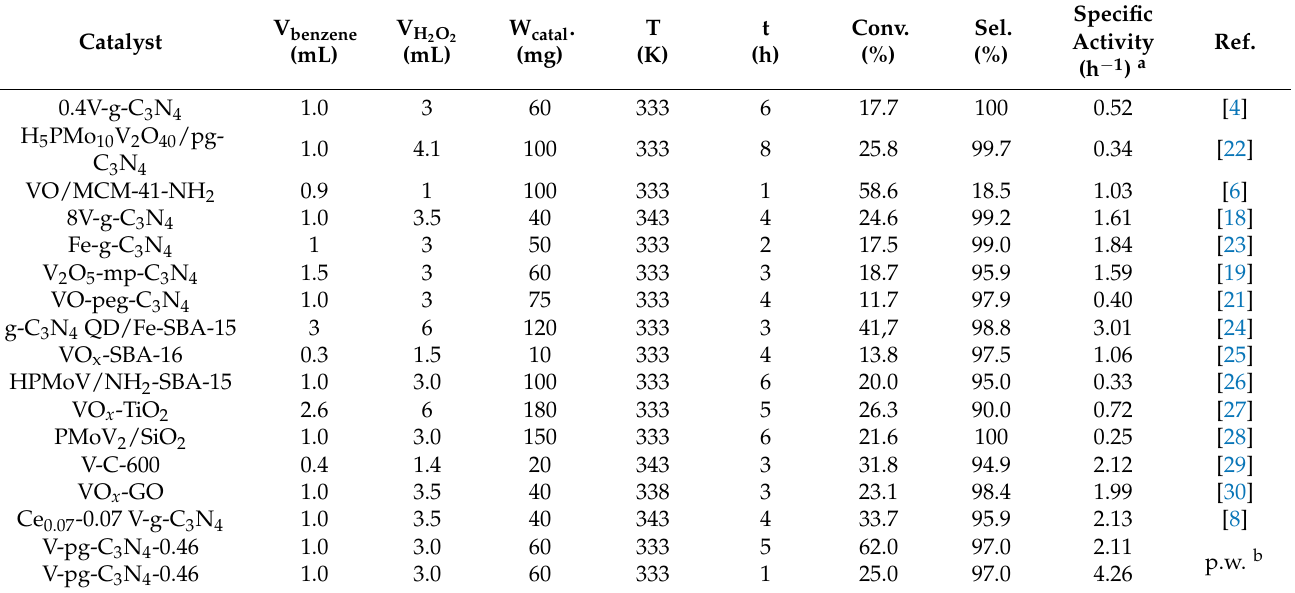
Table 1. The catalytic activity of various vanadia- and g-C 3 N 4 -based catalysts for benzene